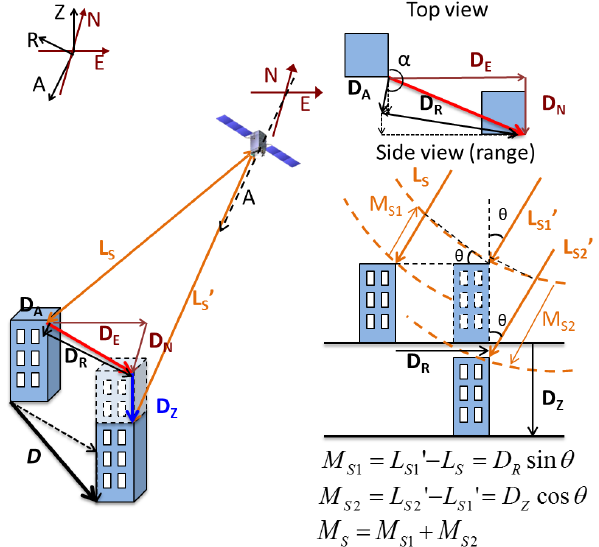
Figure 7. 3-D view and views of the relationship between the 3-D movement and SAR observation from the top and range